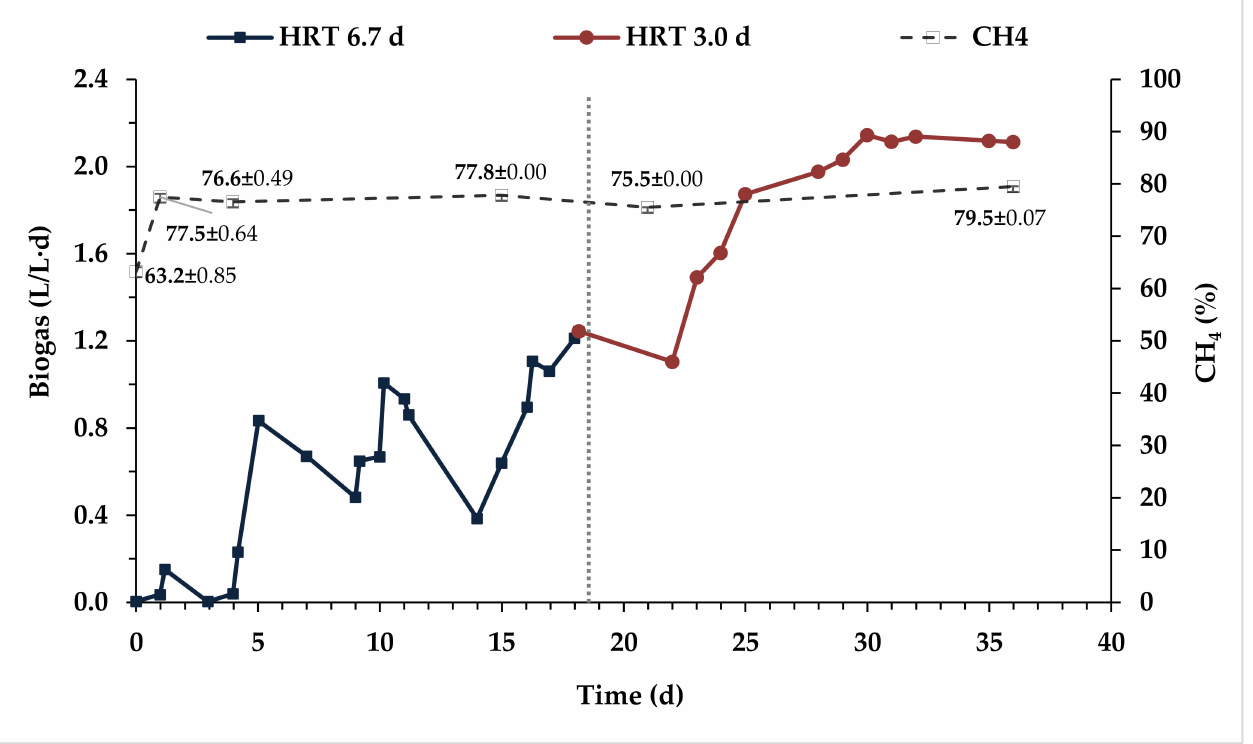
Figure 2. Anaerobic digestion of BWW and PE mixture under fed-batch conditions in the hybrid anaerobic reactor: biogas production and methane composition. HRT = hydraulic retention